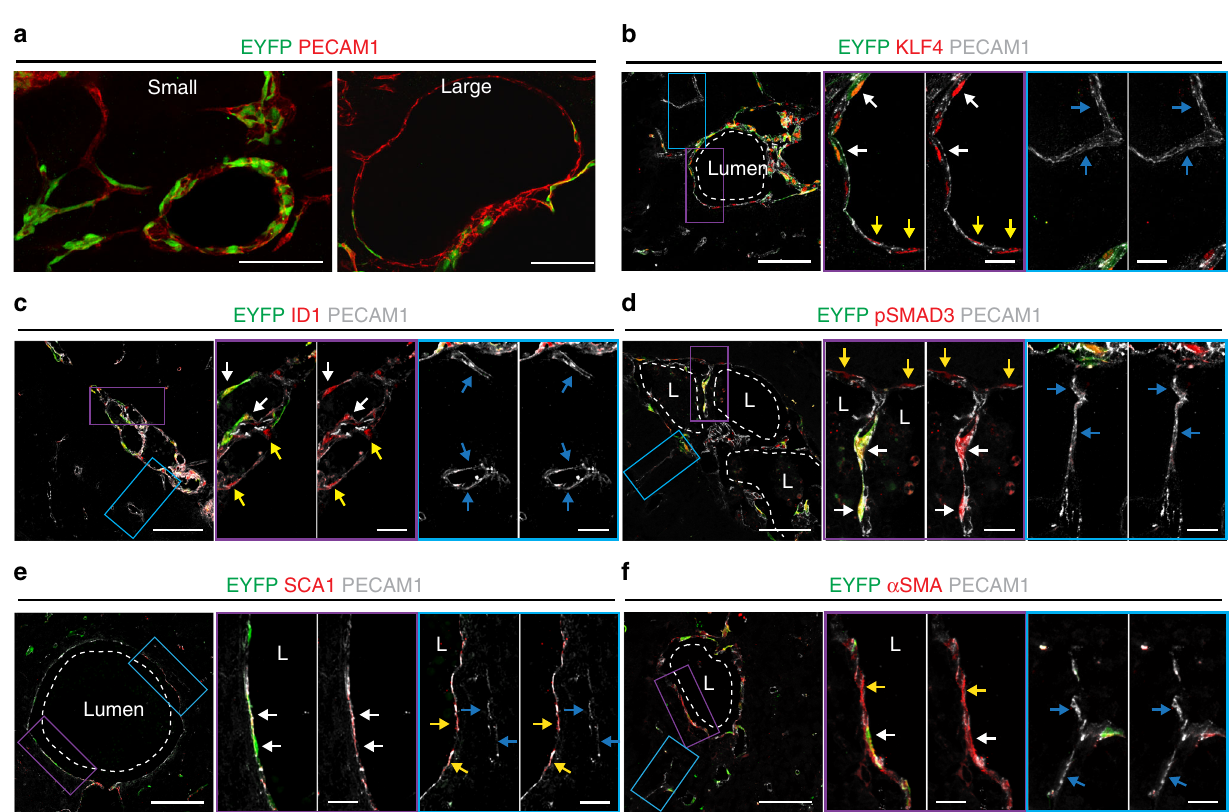
Fig. 5 Ccm3 + / + cells recruited into cavernomas undergo phenotypical modi fi cations. a Representative images from chronic Cdh5(PAC)- Cre-ER T2 / Ccm3 f/f / R26-EYFP mice showing small lesion from P8 mice and large cavernoma from P14 mice cerebellum. b – f Brain sections immunostained for EYFP (green), PECAM1 (grey) and the mesenchymal markers KLF4 ( b ), ID1 ( c ), pSMAD3 ( d ), SCA1 ( e ) and α SMA (red) ( f ). White arrows, endothelial cells positive for EYFP in the cavernomas; yellow arrows, endothelial cells with no recombination in the cavernomas; blue arrows, endothelial cells in normal vessels. Scale bars, 100 μ